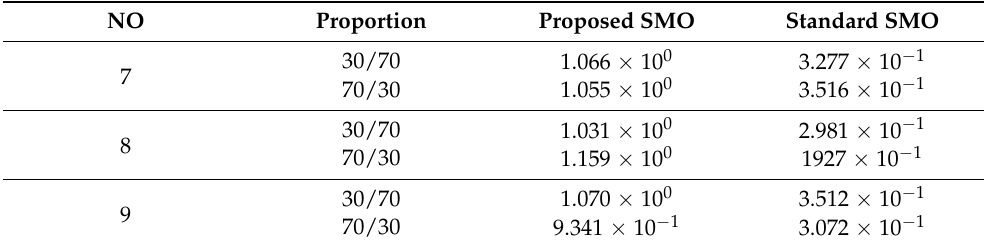
Table 3. Quantitative HV